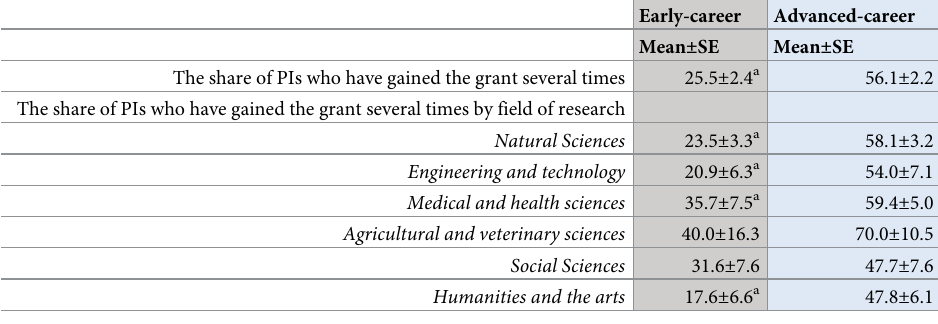
Table 5. The share of PIs who have gained the grant several times across different fields of science for grants awarded by the Estonian Research Council between 2013–2022 (Research question